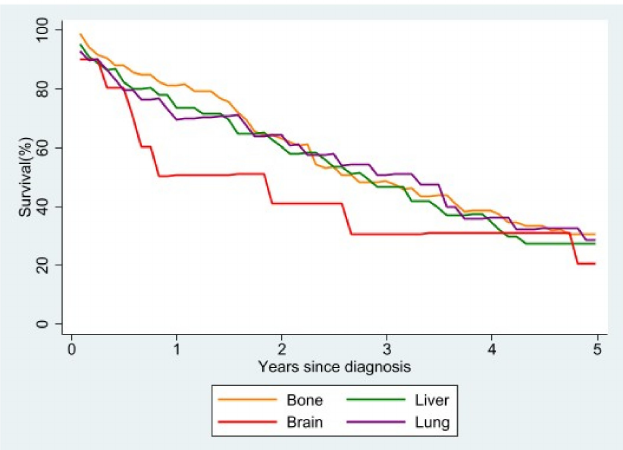
Figure 6. Relative survival of stage IV patients with single metastasis at diagnosis according to site of